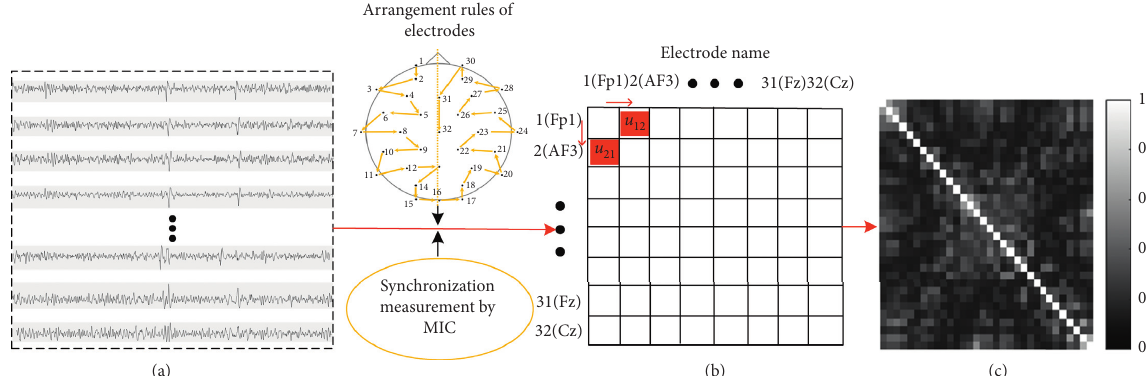
Figure 4: Construction of an MIC gray image according to the global MIC features and arrangement rules of electrodes. (a) Raw EEG signals. (b) MIC feature matrix. (c) MIC gray